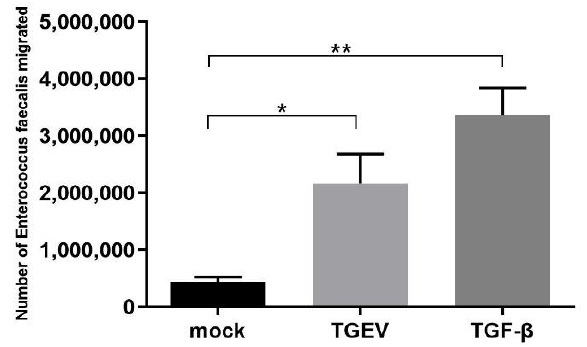
Figure 12. Migration number of E. faecalis after infection. * p < 0.05, ** p < 0.01. Additionally, while the expression of FN and integrin- α 5 in the TGEV- E. faecalis group is higher than that of the TGEV group, the possibility of E. faecalis alone triggering EMT was taken into consideration. Further experiments showed that the IPEC-J2 cells incubated with E. faecalis (MOI = 100) had typical characteristics of EMT cell morphology (Figure A1) and transcription levels of EMT markers (Figure A2). As for the TGEV-infected cells, the EMT marker levels increased with E. faecalis co-existing, which indicated that E. faecalis itself could induce EMT, and this might get enhanced when EMT had already